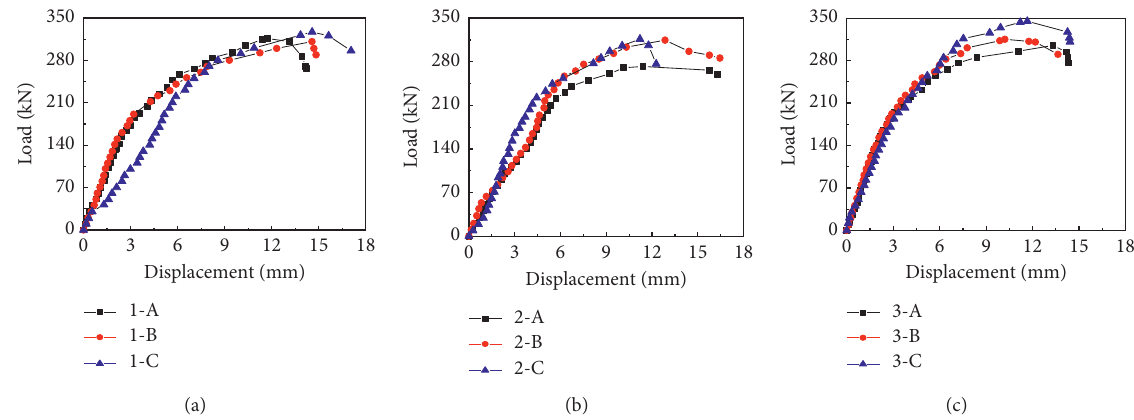
Figure 23: Load-displacement curves. (a) First group. (b) Second group. (c) Third